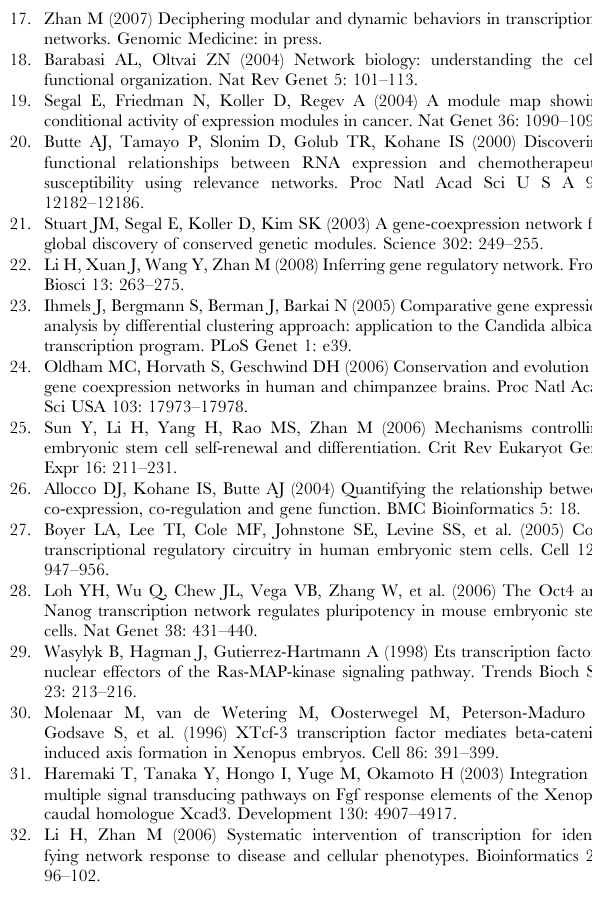
the JAK/STAT pathway (incl. PI3K pathway). The figure legends are the same as for Figure 1. Figure S3 The identification of conserved and divergent co- expression gene clusters from human and mouse ESC-EB data for the TGF-beta network (incl. ACTIVIN/NODAL and BMP pathways). The figure legends are the same as for Figure 1. Figure S4 The identification of conserved and divergent co- expression gene clusters from human and mouse ESC-EB data for the AKT/PTEN pathway. The figure legends are the same as for Figure 1. Found at: doi:10.1371/journal.pone.0003406.s004 (2.08 MB TIF) Figure S5 Topology of the hESC-mESC conserved co-expres- sion network, with illustration of hub genes. Found at: doi:10.1371/journal.pone.0003406.s005 (2.92 MB TIF) Table S1 Lists of examined genes in AKT/PTEN, CELL CYCLE, JAK/STAT (incl. PI3K), TGF-beta (incl. ACTIVIN/ NODAL and BMP) and WNT pathways, along with their expression patterns in ESCs in comparison to EBs and classification into conserved and divergent co-expression gene clusters identified by GSVD and cPAM. Table S2 Conserved transcription factors which showed binding sites among most genes of both human and mouse and statistically